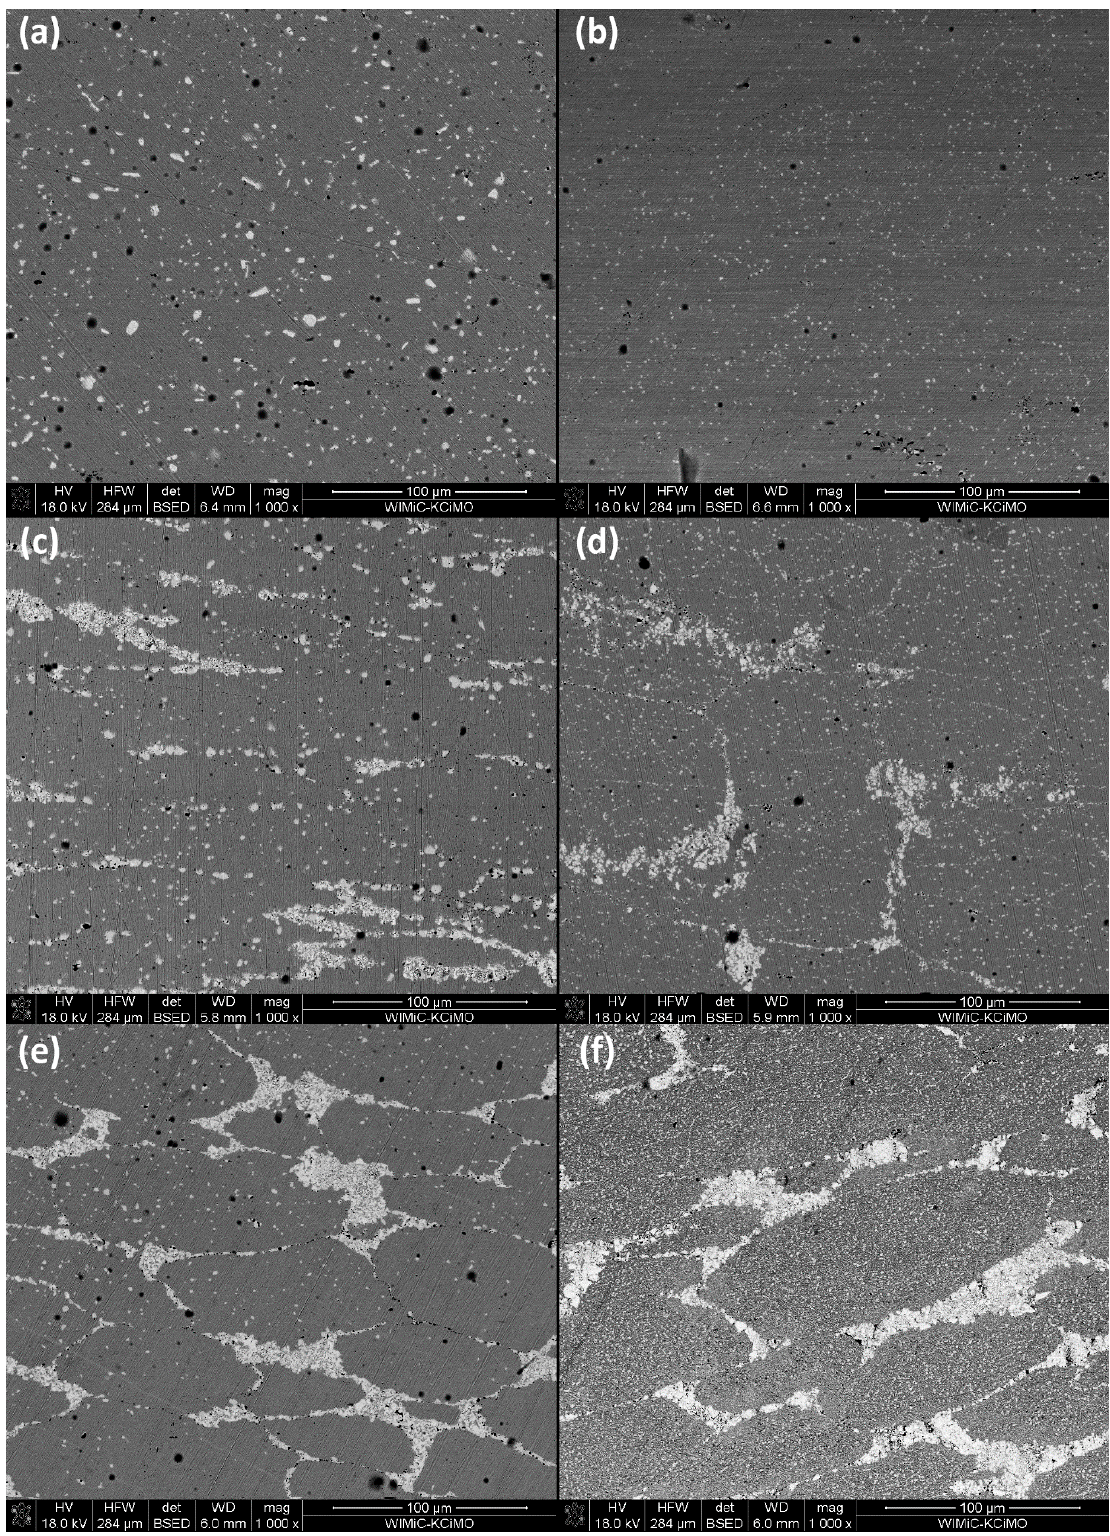
Figure 8. Comparison between heat-treated and reference samples. Compared samples: ( a , b )—Pure Inconel 625 (reference sample); ( c , d )—NbC 5%, ( e , f )—NbC 20%. Left-sided materials were heat-treated, while right-sided images are matching composites observed before this process.